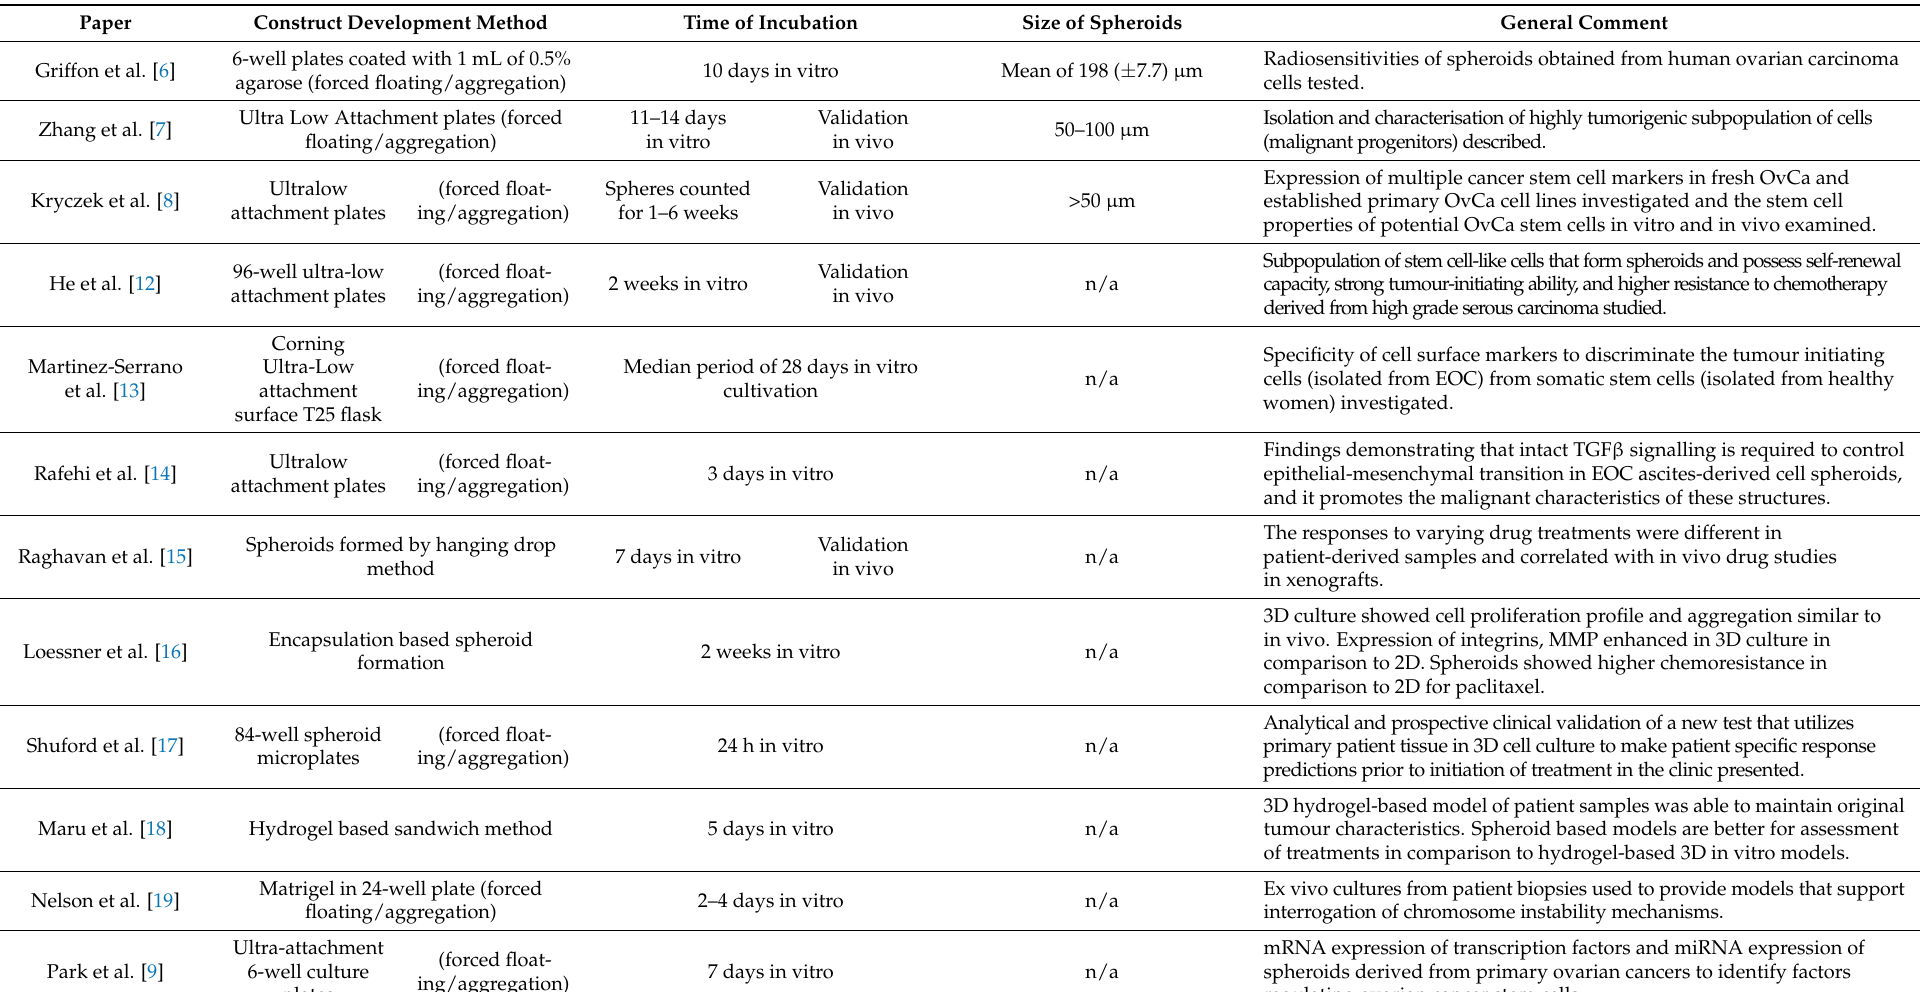
Table 5. Summary of papers, which used primary patient specimens to develop spheroid models—part